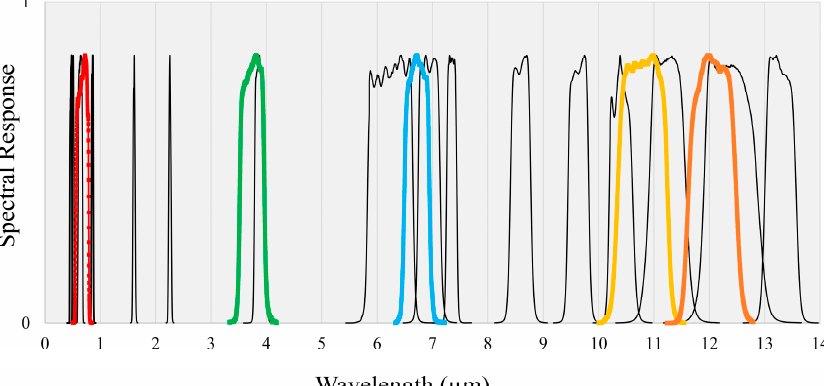
Figure 3. Comparison of spectral response functions (SRF) for Communications, Oceans, and Meteorological Satellite Meteorological Imager (COMS MI) and Himawari-8 Advanced Himawari Imager (H8 AHI) using spectral responsivity data supplied by the National Meteorological Satellite Center (NMSC) and Japan Aerospace Exploration Agency (JAXA). The black-colored curves represent H8 SRF and the colored curves represent COMS SRF. Table 2. Detailed comparison of the spectral bands for the meteorological satellite images mentioned in this study. Spectral characteristics of GEO-KOMPSAT-2A (GK2A) are also included to show the similarity of the H8 AHI and GK2A Advanced Meteorological Imager (AMI) sensors. The spectral bands used in this study are emphasized in bold text with an asterisk placed next to the band number. Band